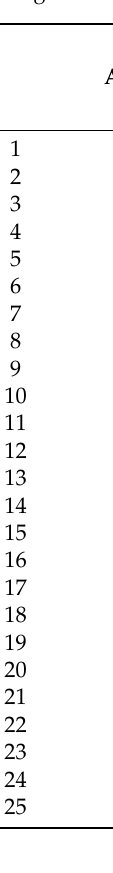
Table 1. Demographic data of all patients, including the year of transplantation, immunosuppressive agent, and doses in mg. M: male; F: female; YearTX: year of kidney transplant; Cicl: ciclosporine; AZ: azathioprine; Ev: everolimus; S: